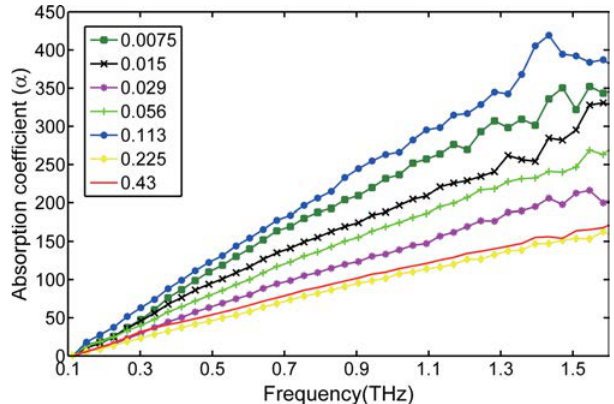
Fig. 4. T-rays absorption coe±cients of HA protein in sol- ution at concentrations from 0.0075 to 0.43 mg/ml.